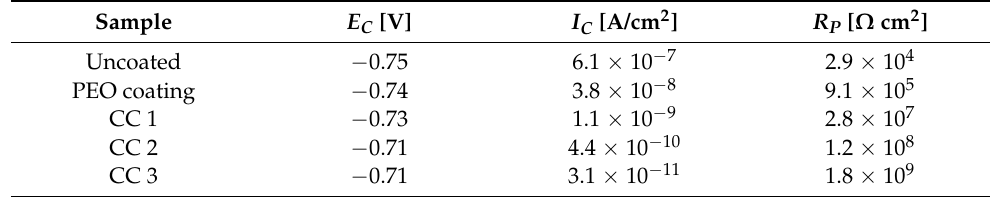
Table 2. Corrosion properties (corrosion potential, E C , corrosion current density, I C , polarization resistance, and R P ) of samples made of AMg3 aluminum alloy with various types of surface treatment.